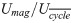
Normalized velocity magnitude (Umag/Ucycle¯) at three selected cut planes in the aneurysm sac.Each row shows one cardiac phase. Note that for better visibility, every third vector in each direction is shown.